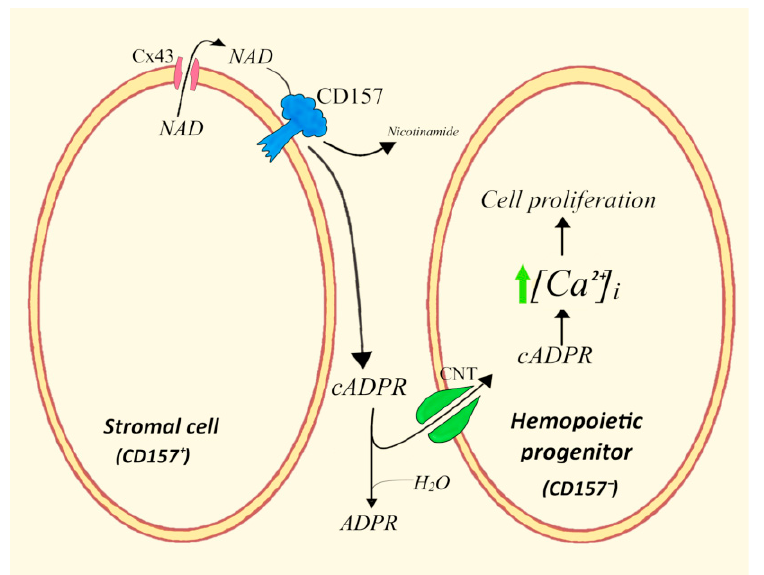
Figure 6. Paracrine interactions between CD157-expressing stromal cells and human hemopoietic cells. The stroma-produced cADPR determines a calcium-mediated expansion of human hemopoietic cells. CNT, concentrative nucleoside transporter.